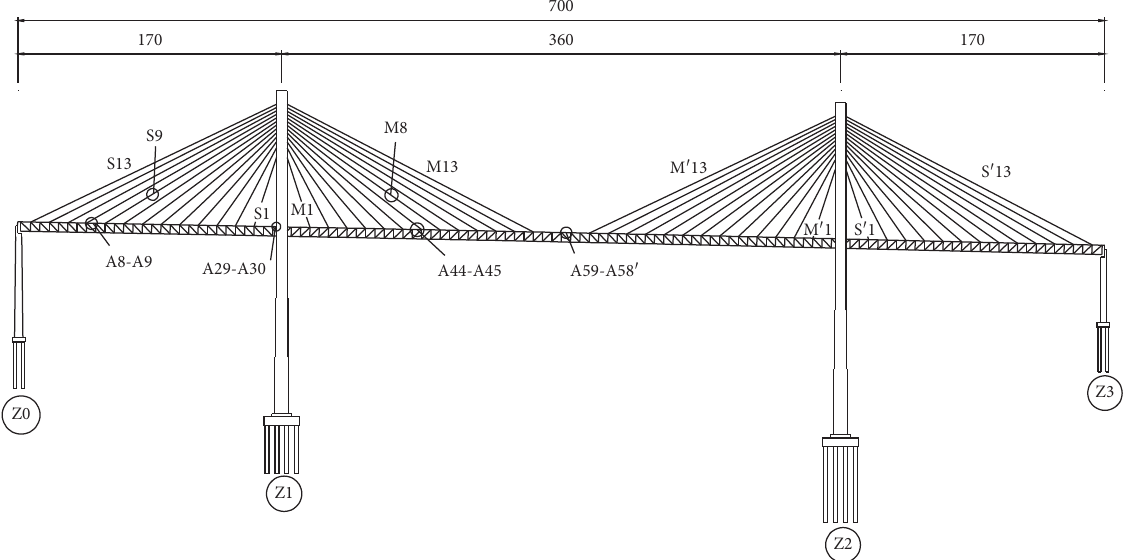
Figure 11: Failed members and corroded bridge sections (units: m).